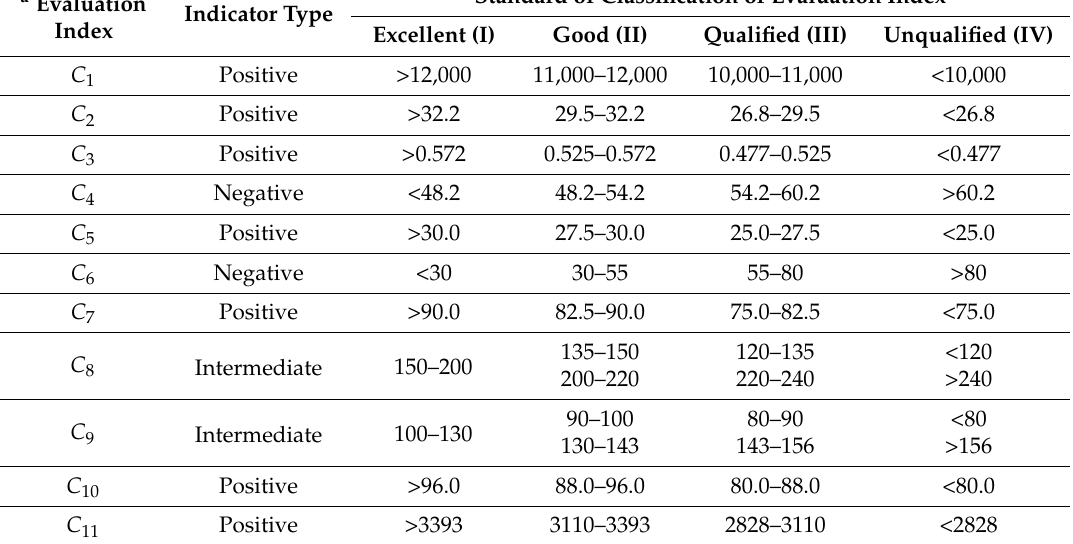
Table 8. Evaluation index system and standard of classification of Jiangxi Province regional water usage efficiency